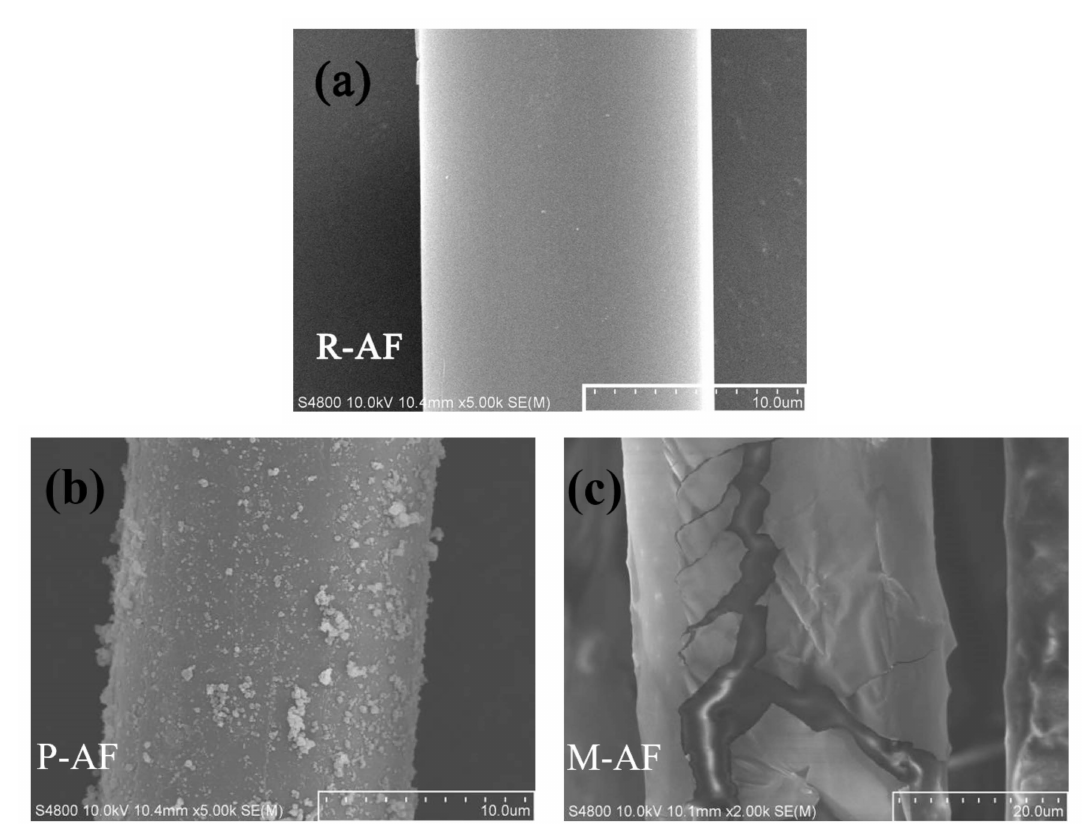
Figure 7. Surface morphologies of ( a ) R-AF, ( b ) P-AF, and ( c ) M-AF.